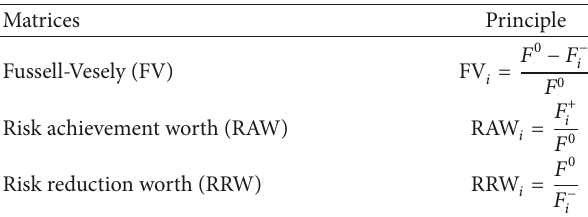
Table 1: Importance